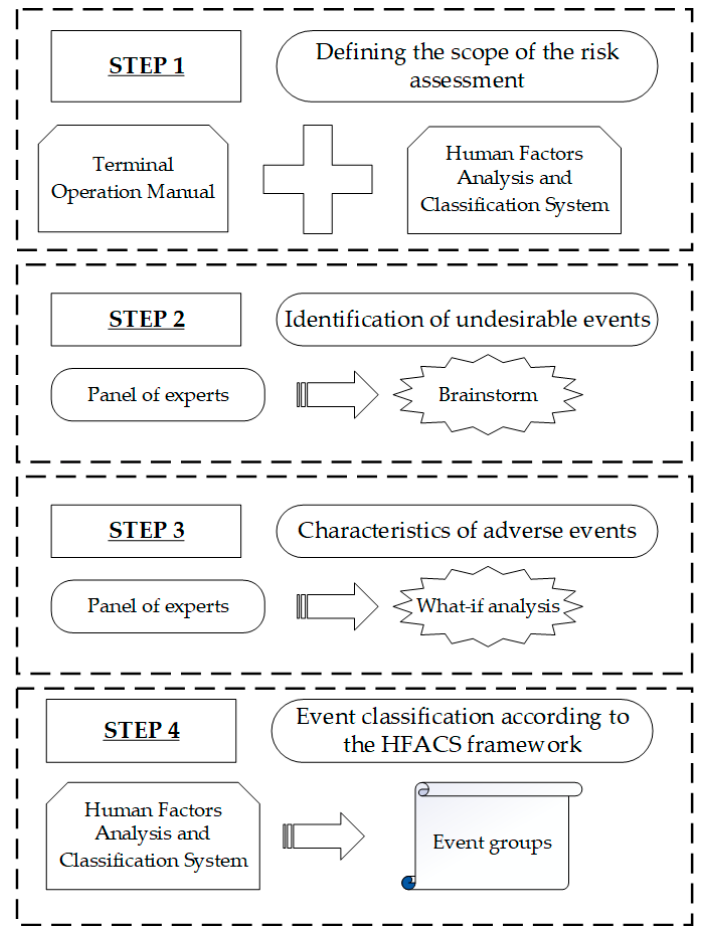
Figure 2. Methodology of qualitative analysis.